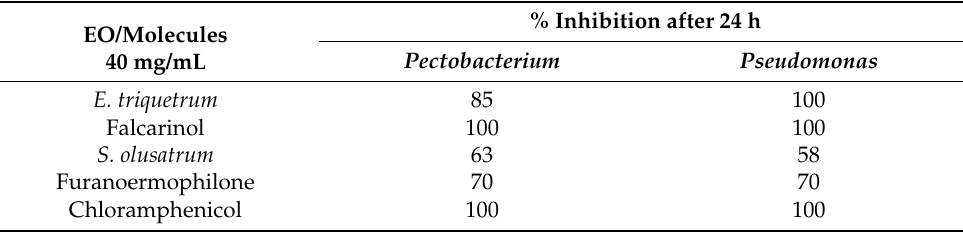
Table 6. Antibacterial activity of essential oils and the major